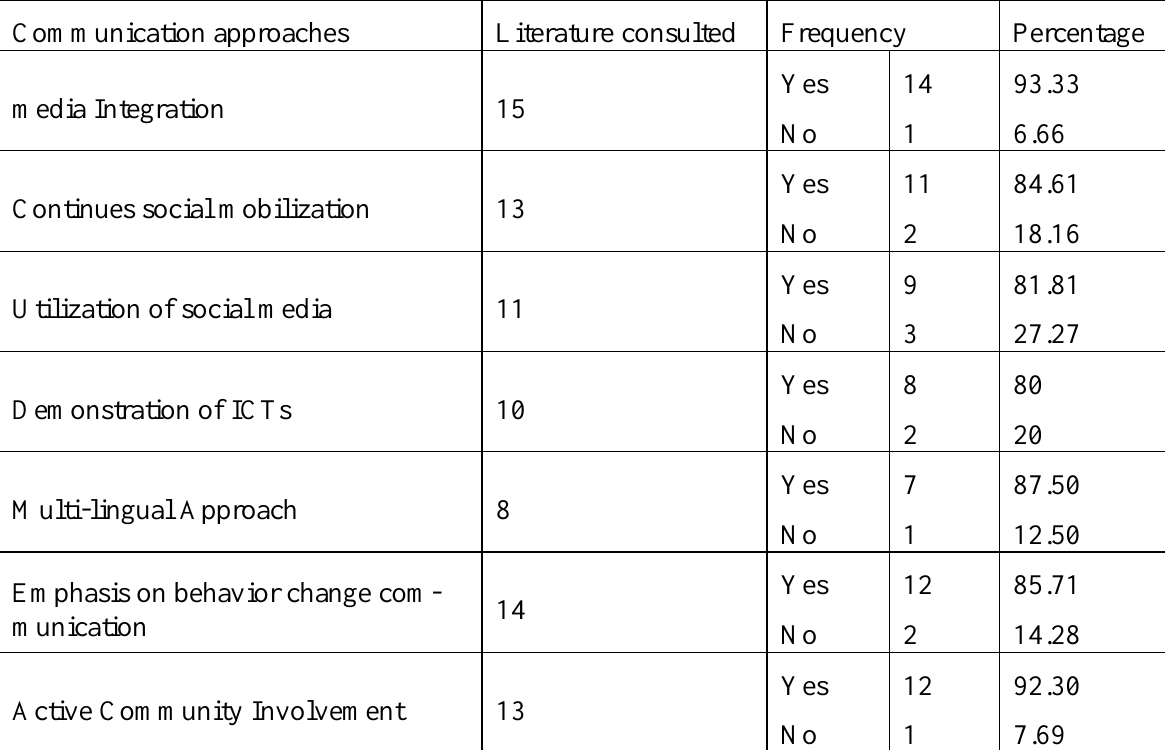
Table 3: Further confirmation of the level of effectiveness of the highlighted communica- tion approaches above that can be used towards achieving Universal Health Coverage through Social Health